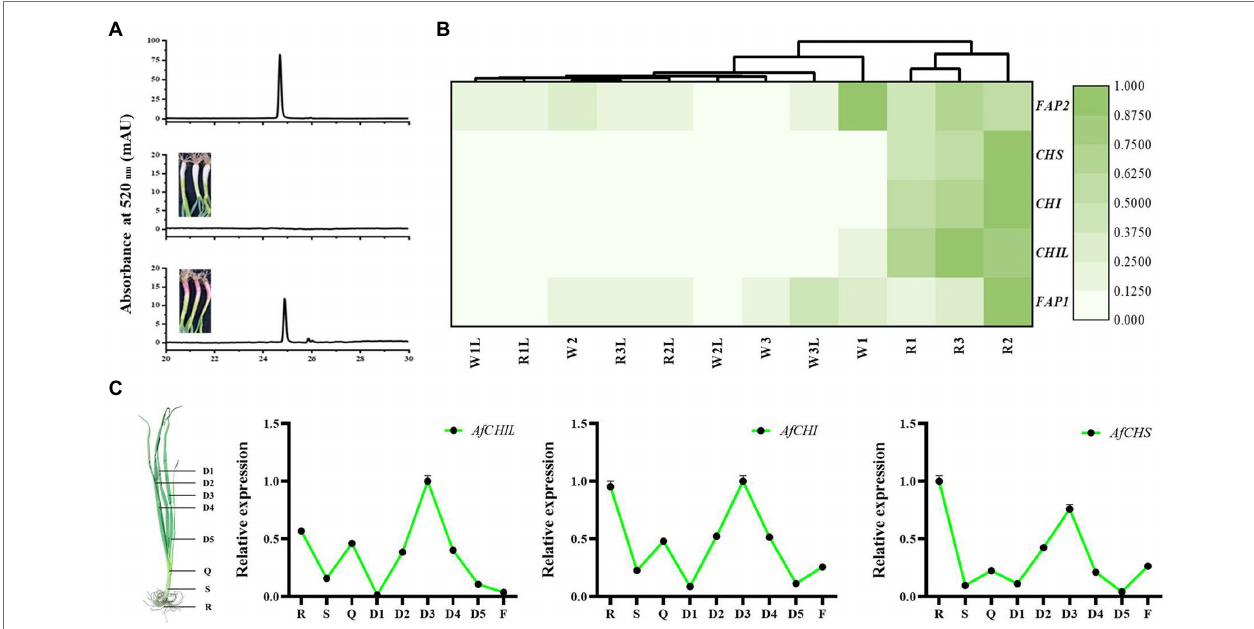
FIGURE 3 | AfCHIs involved in flavonoid pathway of Allium fistulosum . (A) Analysis of anthocyanin content between W and R. (B) Transcriptome analysis of the effect of CHS and CHIs on anthocyanin accumulation. W1, W2, and W3 were stems of W, W1L, W2L, and W3L were leaves of W. R1, R2, and R3 were stems of R. R1L, R2L, and R3L leaves of R. (C) Expression of CHS and CHIs in different tissues of A. fistulosum. D1(the first leaf), D2(the second leaf), D3(the third leaf), D4(the fourth leaf), D5(the fifth leaf), Q(sheath), S(stem), R(root), and F(flower) were used for expression